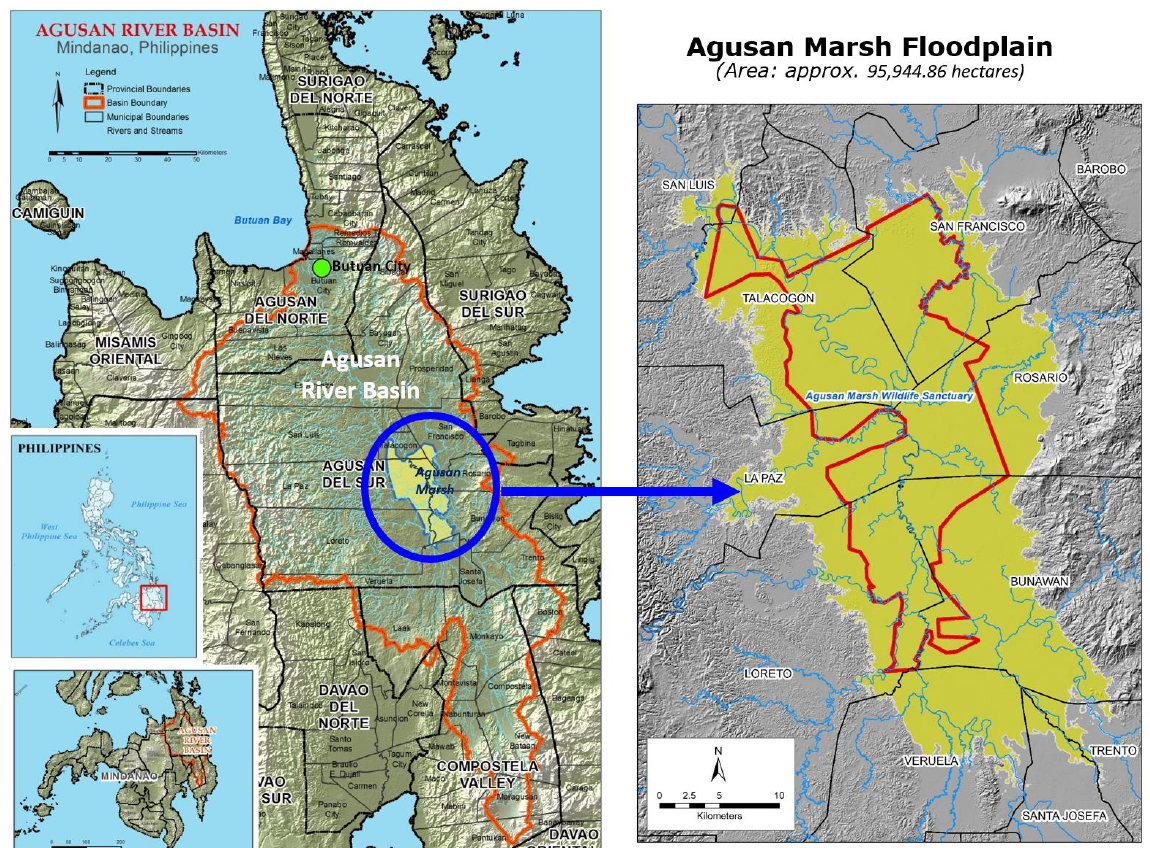
Figure 1 . Location of the Agusan Marsh within the Agusan River Basin (ARB) in Mindanao, Philippines. Within the marsh floodplain is the Agusan Marsh Wildlife Sanctuary (AMWS), a protected area.